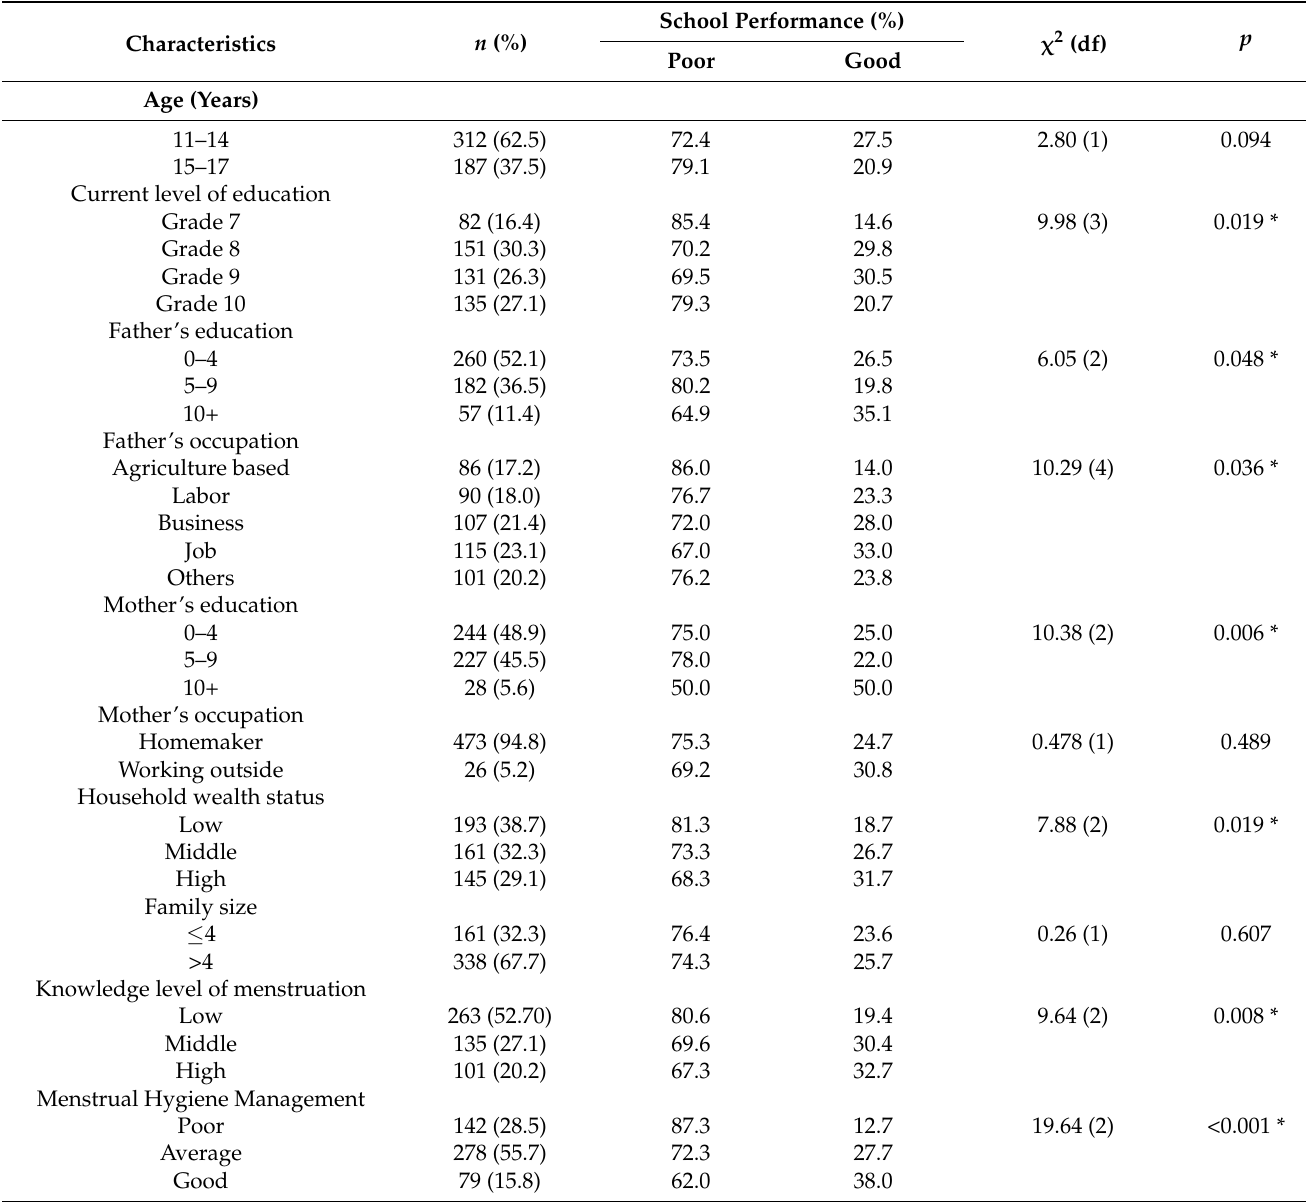
Table 1. Bivariate analysis of socio-demographic characteristics and school performance among school-going girls (N = 499).